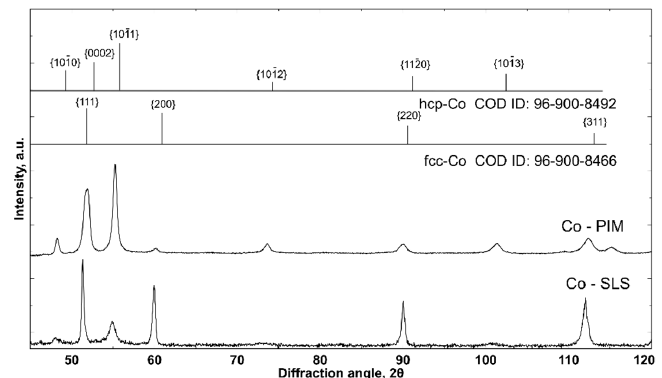
Figure 1. X-ray diffraction patterns of Co-Selective Laser Sintering (Co-SLM) and Co-Powder Injection Molding (Co-PIM) samples.